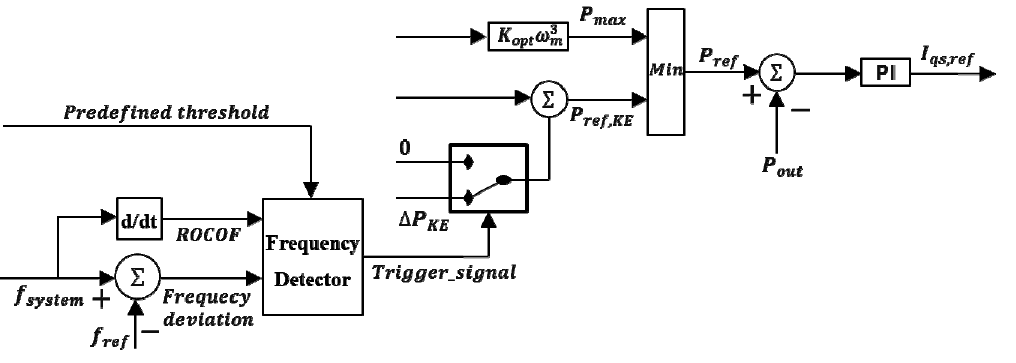
Figure 9. Modified frequency detection and trigger signal